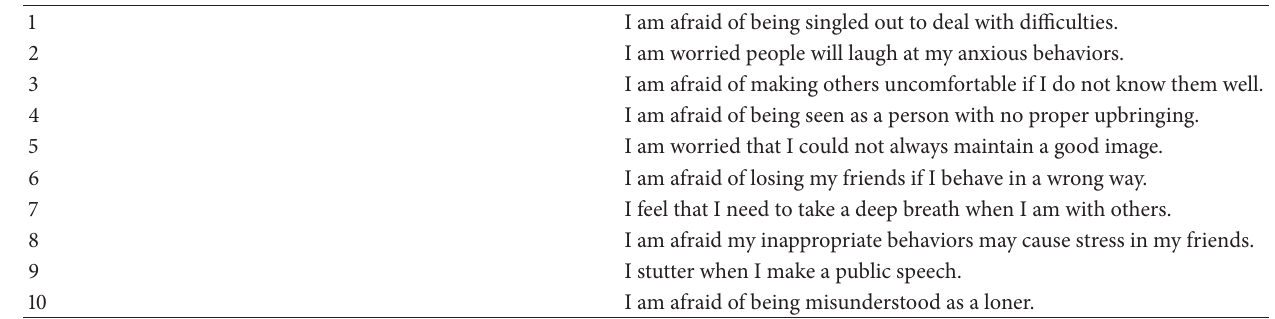
Table 1: 10 new items of social anxiety scale.